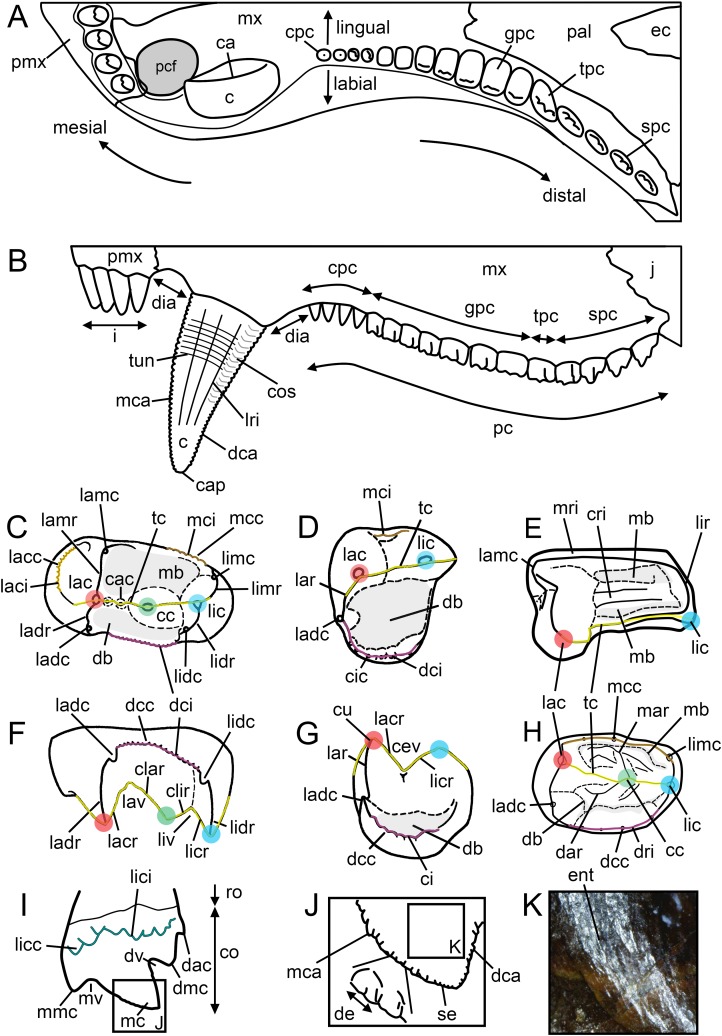
Dental terminology used in this study.(A and B) Diademodon rostrum in (A) palatal and (B) labial views; (C and F) idealized right upper gomphodont postcanine in (C) apical and (F) distal views (based on the upper gomphodont postcanine of Scalenodon angustifrons by Hopson, 2005; modified); (D and G) idealized left lower gomphodont postcanine in (D) apical and (G) distal views (based on the lower gomphodont postcanine of Scalenodon angustifrons by Hopson, 2005; modified); (E) upper right gomphodont postcanine of Menadon besairiei (UA 10601) in apical view; (H) upper right gomphodont postcanine of Diademodon tetragonus (SAM-PK-571) in apical view; (I) idealized sectorial postcanine of Diademodon tetragonus in lingual view (based on the second right upper sectorial postcanine of Diademodon tetragonus BP/1/4529); (J) apex of main cusp of an upper sectorial postcanine of Diademodon tetragonus with close up on the denticles, in labial view; (K) close up on the enamel surface texture of the second right upper sectorial postcanine of Diademodon tetragonus (BP/1/4529). Abbreviations: c, canine; ca, carina; cac, central accessory cusp; cap, crown apex; cc, central cusp (in green); cev, central valley; ci, cingulum; cic, cingular cuspules; clar, centrolabial ridge; clir, centrolingual ridge; co, crown; cos, concave surface; cpc, conical postcanine; cri, central ridge; cu, cusp; db, distal basin (in light grey); dac, distal accessory cusp; dar, distal accessory ridge; dca, distal carina; dcc, distal cingular cuspule; dci, distal cingulum (in violet); de, denticle; dia, diastema; dmc, distal main cusp; dri, distal ridge; dv, distal valley; ec, ectopterygoid; ent, enamel texture; gpc, gomphodont postcanine; i, incisor; j, jugal; lac, labial cusp (in red); lacc, labial cingular cusp; laci, labial cingulum (in orange); lacr, labiocentral ridge; ladc, labiodistal accessory cusp; ladr, labiodistal ridge; lamr, labiomesial ridge; lar, labial ridge; lav, labial valley; lic, lingual cusp (in blue); licc, lingual cingular cuspule; lici, lingual cingulum (in turquoise); licr, linguocentral ridge; lidc, linguodistal accessory cusp; lidr, linguodistal ridge; limc, linguomesial accessory cusp; limr, linguomesial ridge; lir, lingual ridge; liv, lingual valley; lri, longitudinal ridge; mar, mesial accessory ridge; mb, mesial basin (in light grey); mc, main cusp; mca, mesial carina; mcc, mesial cingular cuspule; mci, mesial cingulum (in beige); mmc, mesial main cusp; mri, mesial ridge; mv, mesial valley; mx, maxilla; pal, palatine; pc, postcanine; pcf, paracanine fossa; pmx, premaxilla; ro, root; se, serration; spc, sectorial postcanine; tc, transverse crest (in yellow); tpc, transitional postcanine; tun, transverse undulation.